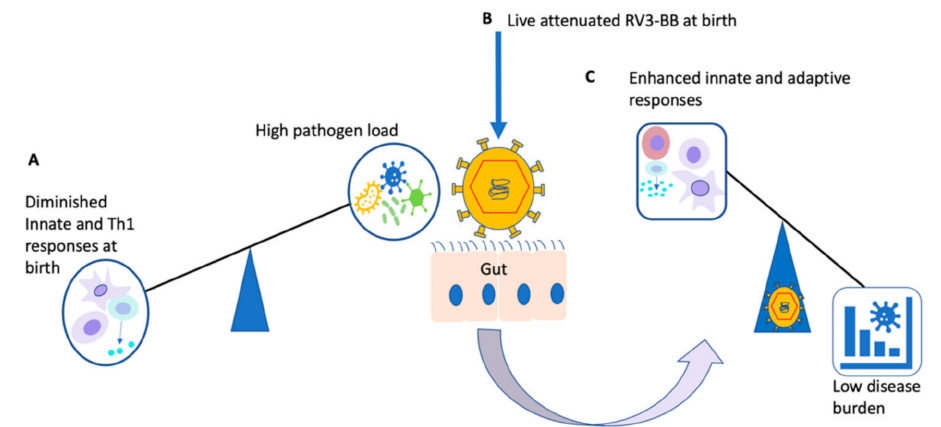
Figure 2. Illustration of potential beneficial off-target effects of live-attenuated RV3-BB vaccine: At birth and in younger infants, the immune system generally favours inhibition of Th1 and innate responses ( A ). Live-attenuated vaccines such as RV3-BB administered at birth ( B ) would circumvent the imbalance towards enhanced immune responses ( C )